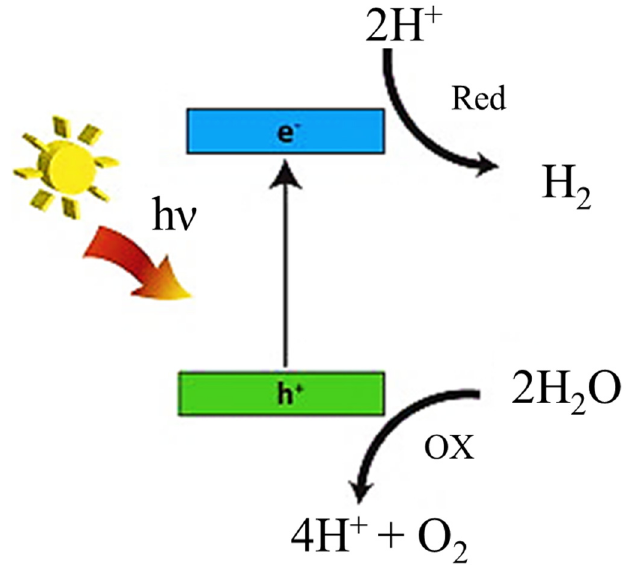
Figure 3. A simple photocatalytic procedure [19].